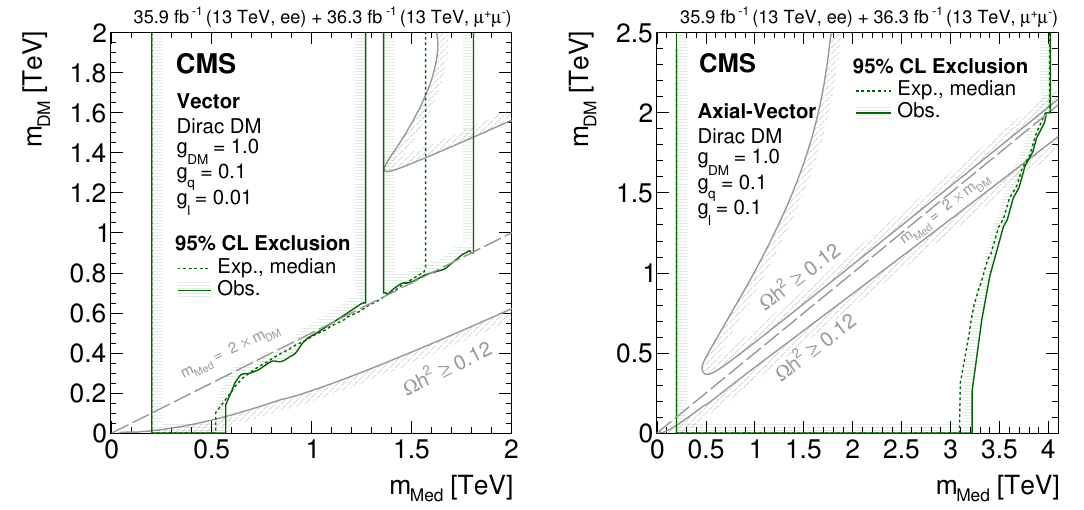
Figure 8 . Limits at 95% con(cid:12)dence level for the masses of the DM particle, which is assumed to be Dirac fermion, and its associated mediator, in a simpli(cid:12)ed model of DM production via a vector (left) or axial vector (right) mediator. The parameter exclusion is obtained by comparing the limits on product of the production cross section and the branching fraction for decay to a Z boson, with the values obtained from calculations in the simpli(cid:12)ed model. For each combination of the DM particle and mediator mass values, the width of the mediator is taken into account in the limit calculation. The lines with the hatching represents the excluded regions. The solid grey lines, marked as \(cid:10) h 2 (cid:21) 0 : 12", correspond to parameter regions that reproduce the observed DM relic density in the universe [4, 26, 62, 63], with the hatched area indicating the region where the DM relic abundance exceeds the observed